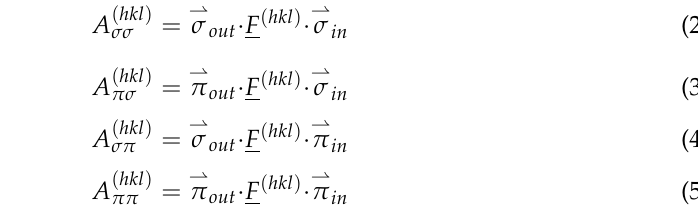
( i ) of the polarization axis